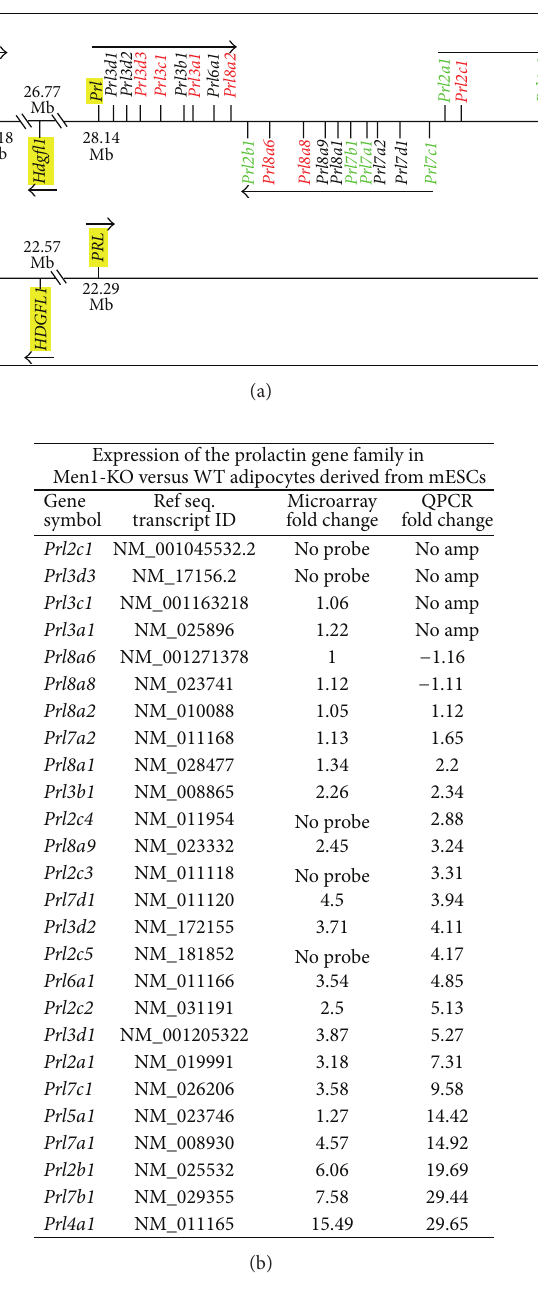
Figure 2: Prolactin family genes are upregulated in adipocytes derived from Men1-KO mESCs. (a) Schematic diagram comparing the mouse prolactin gene family locus with the syntenic human locus. The mouse prolactin gene family locus on chromosome 13 is shown on top and the syntenic human locus on chromosome 6 is shown at the bottom. Red, genes not differentially expressed in Men1-KO versus WT adipocytes or that did not yield a PCR product. Green, genes with the highest fold change ( > 5-fold) in Men1-KO versus WT adipocytes. Yellow highlight, genes present in both mouse and human. Arrows indicate the orientation of the coding strand. Chromosomal location in megabases (Mb) is from the UCSC genome browser using mouse genome version mm9 and human genome version hg19. (b) Relative expression of prolactin family genes. Prolactin family genes ( 𝑛 = 26 ) were analyzed by QPCR using RNA isolated from adipocytes derived by in vitro differentiation of WT or Men1-KO mESCs. Microarray data and QPCR relative fold change (normalized to Gapdh) are shown. “No probe” indicates genes not present on the microarray, and “no amp” indicates genes that did not yield a PCR